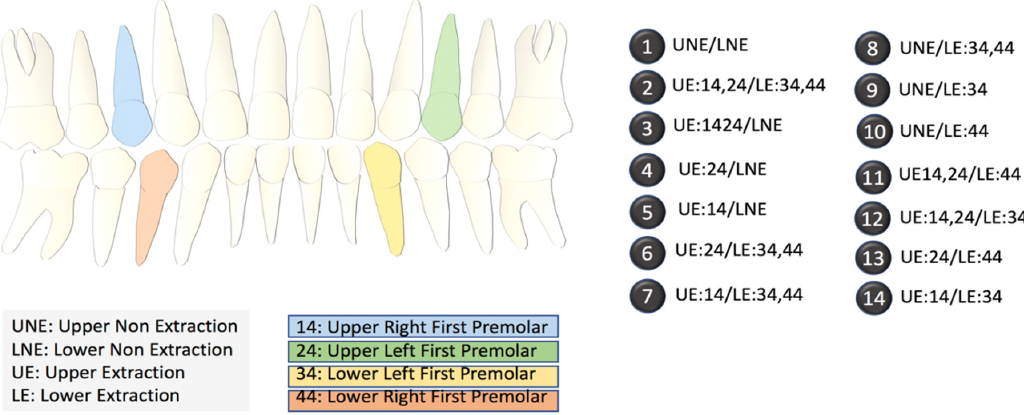
Figure 2. Index of the different extraction options. The diagram on the left shows the locations of the upper and lower premolars. The 14 options on the right list the specific extraction procedures in terms of the locations of the teeth. NE refers to no extraction.